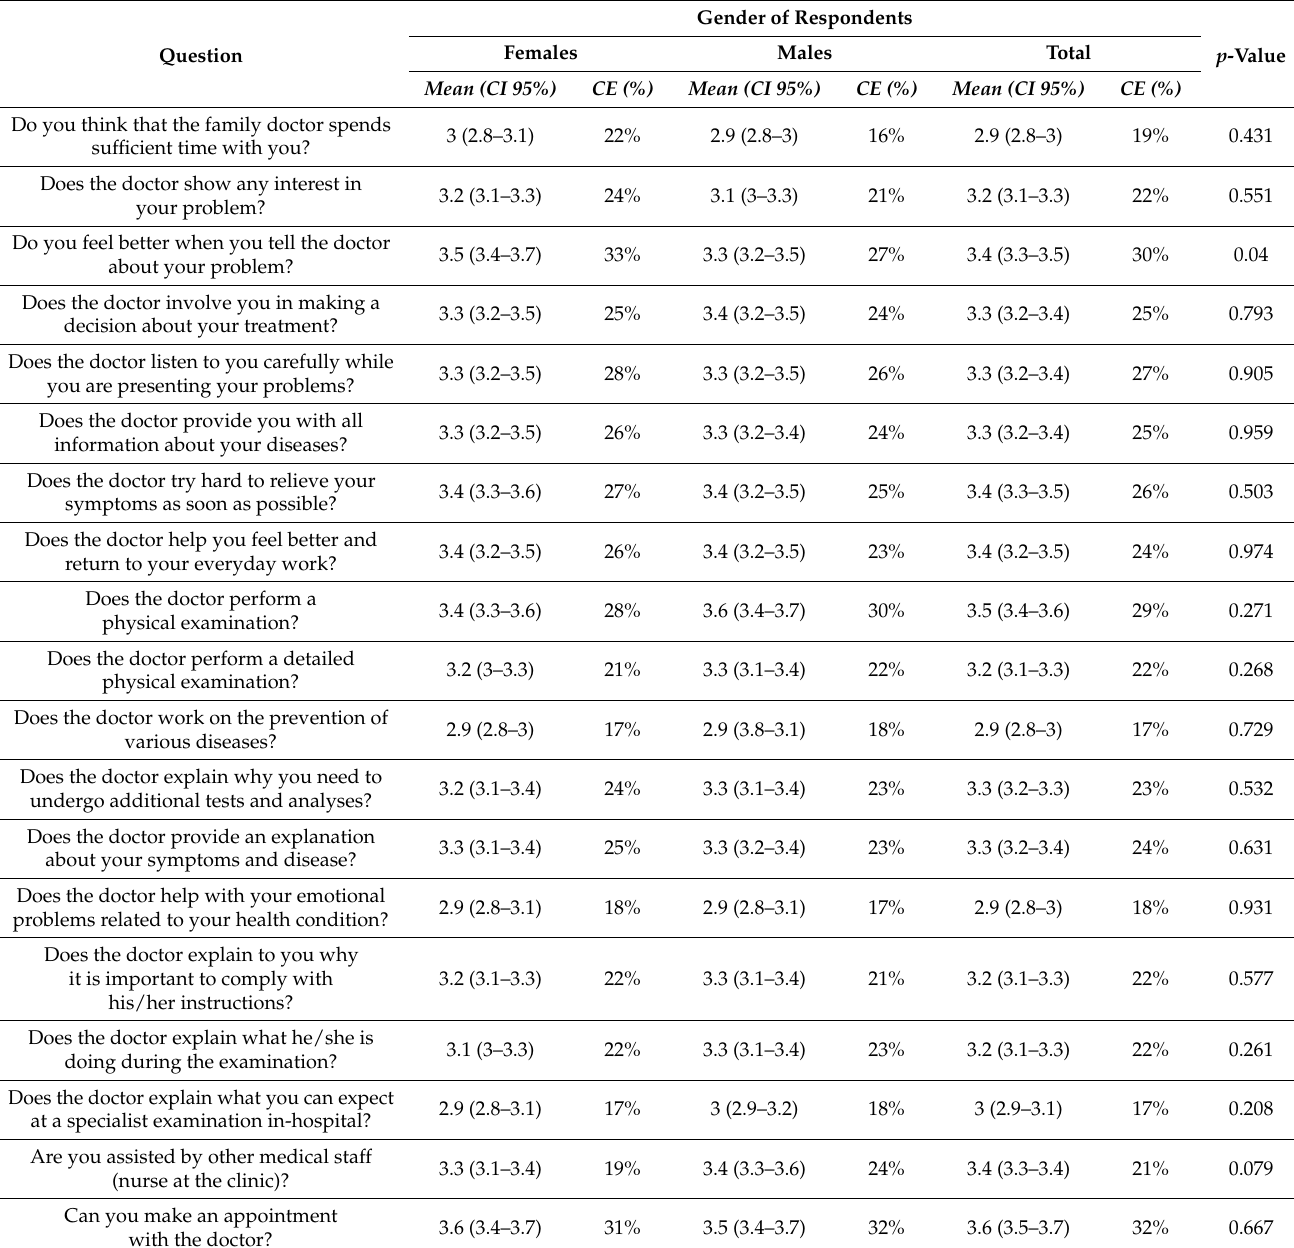
The overall composite score for females was 3.2 (95% CI: 3.1–3.3) and 3.2 (95% CI: 3.1–3.4) for males. There is no significant difference between the composite scores for females or males or with composite score for the whole sample of 3.2 (95% CI: 3.2–3.3). There were no statistically significant differences in the mean scores between the gender groups across the items except for the item “Do you feel better when you tell the doctor about your problem?” where the score of 3.5 (95% CI: 3.4–3.7) was significantly higher in females than males ( p = 0.04). The ceiling effect was 24% overall in females (ranging from 17% to 33%) and 23% in males (ranging from 17% to 32%) with no significant differences. See Table 2 for details. Table 2. Satisfaction with health care in the adult population of the Federation of Bosnia and Herzegovina during the COVID-19 pandemic by